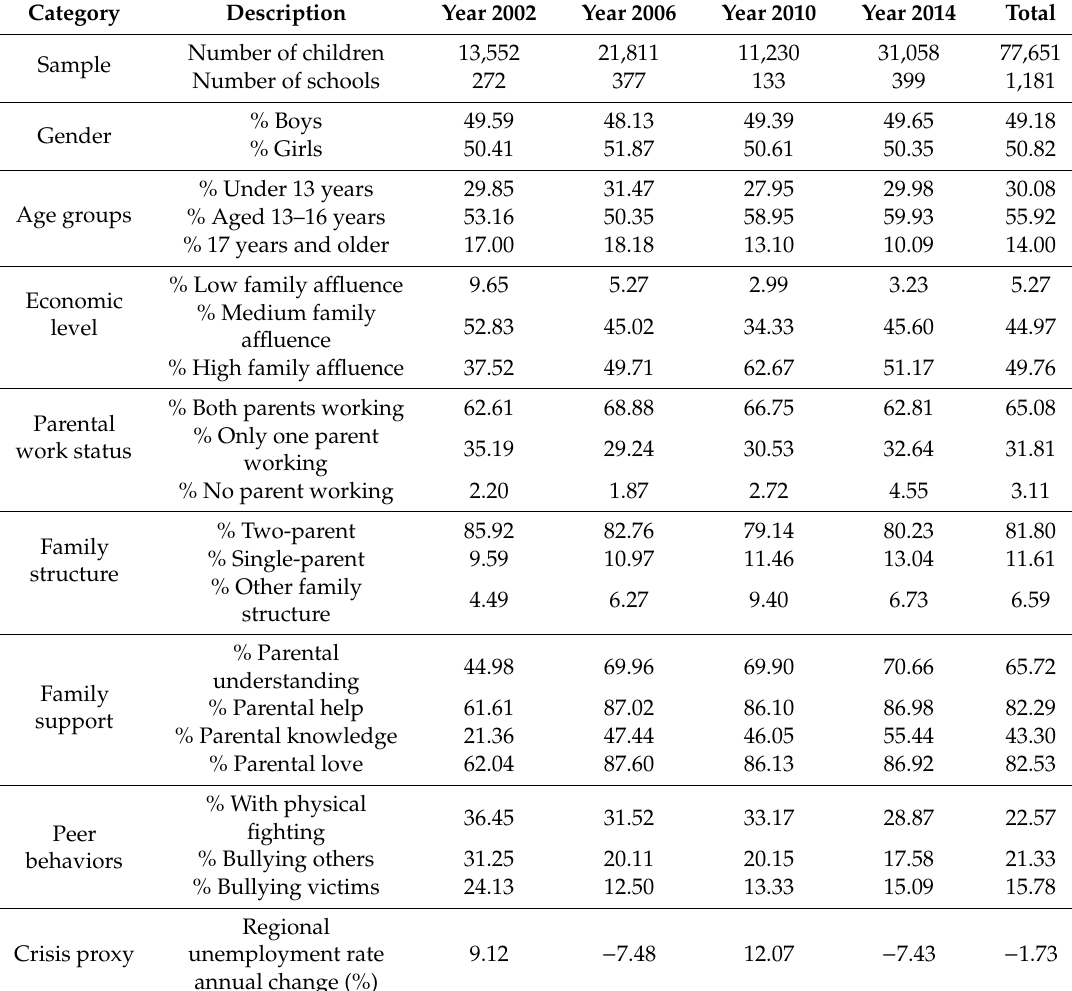
Table 2. Descriptive analysis of the independent